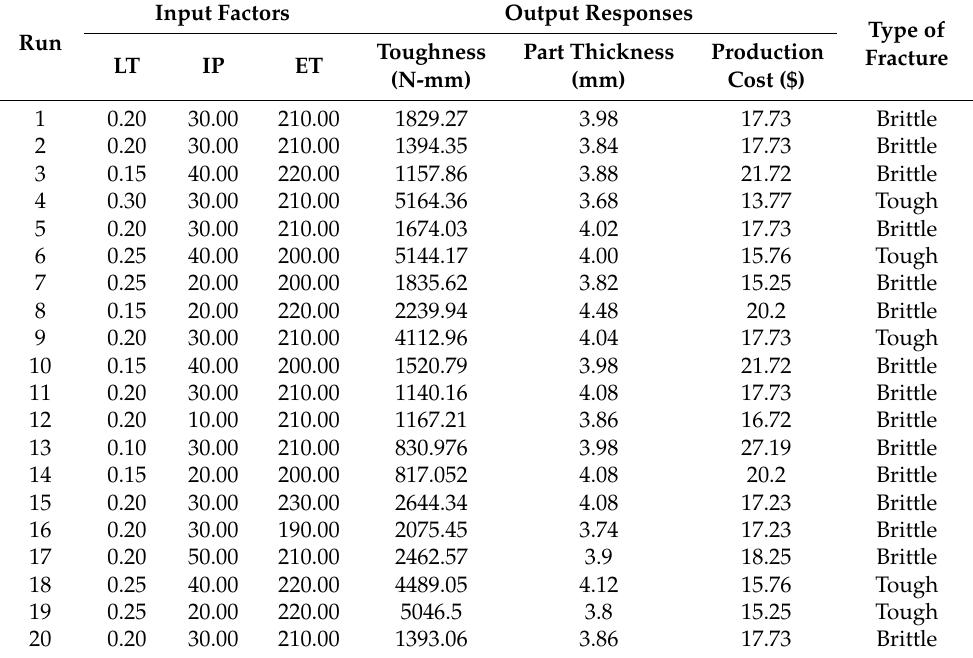
Table 2. Experimental data for design of experiments (DOE)